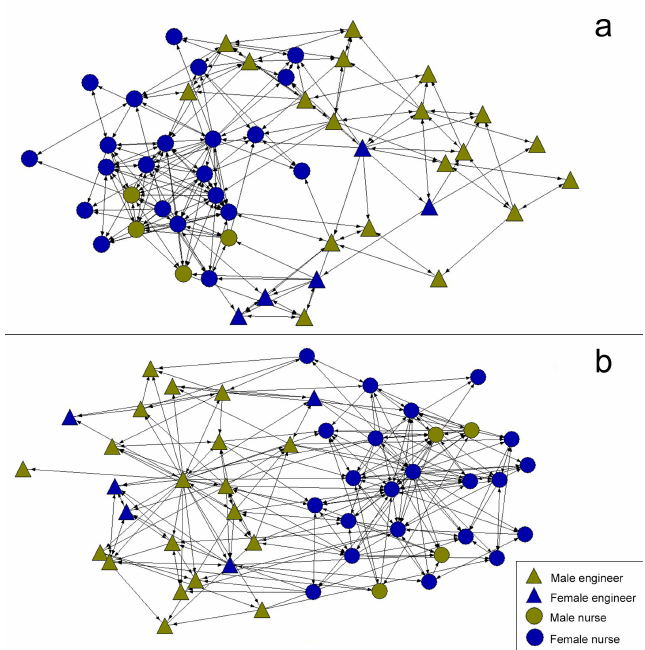
Figure 3. Post-intervention friendship network ( a ) and collaboration network ( b ).